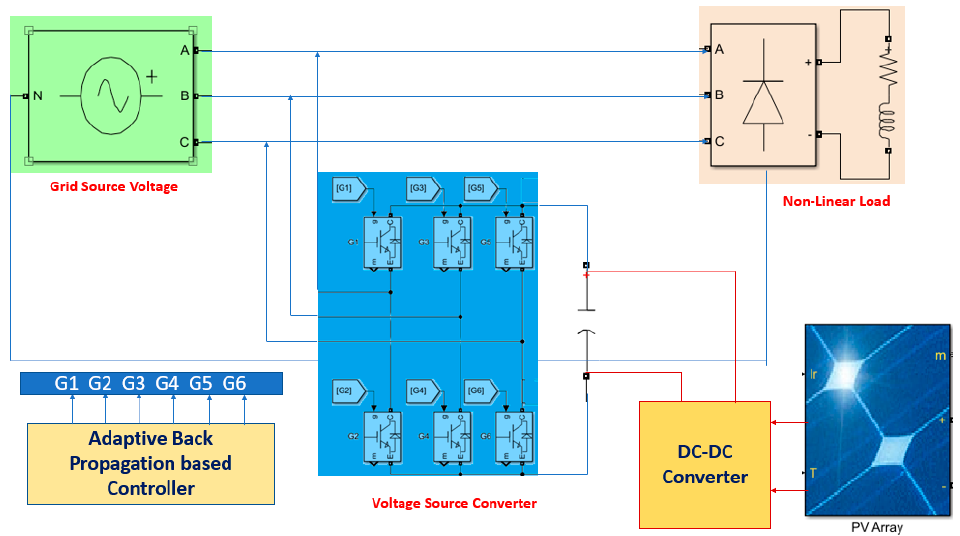
Figure 1. Schematic diagram of the ANN-BP control strategy for the grid-tied solar PV System. The three-phase balanced non-linear load was linked to three-phase grid sources. Load currents were sensed and given to the adaptive ANN controller to create the signal pulses of the VSC. The DC link voltage of the VSC was fed from the solar PV Panel. The panel voltage was boosted using a DC–DC boost converter, and an incremental conductance method was used to extract maximum power from the sun.